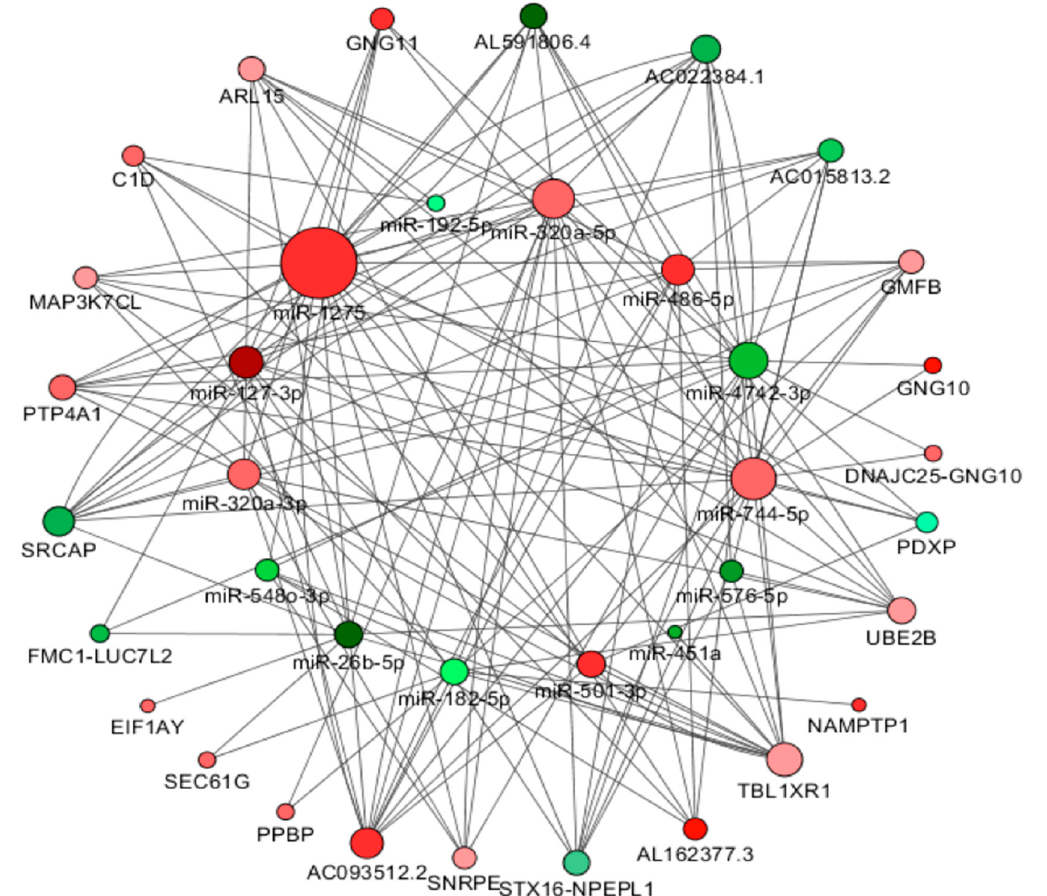
Figure 1. Graphical representation of miRNA-target genes interaction network using Cytoscape v3.7.2. The node intensity color is proportional to the log2 fold change values in the DE analysis (red: under-regulated; green: upregulated); the node size is proportional to the number of miRNA/mRNA connections. Please note that only downregulated genes were selected as targets of upregulated miRNAs (in the lower semicircle) and vice versa for downregulated miRNAs (in the upper semicircle). No molecular pathways involving the most targeted genes survived the adjustment for multiple data; the only trend to significance was obtained by the KEGG chemokine signaling pathway that enclosed the genes GNG10, GNG11 and PPBB ( p = 0.034, adjusted p >